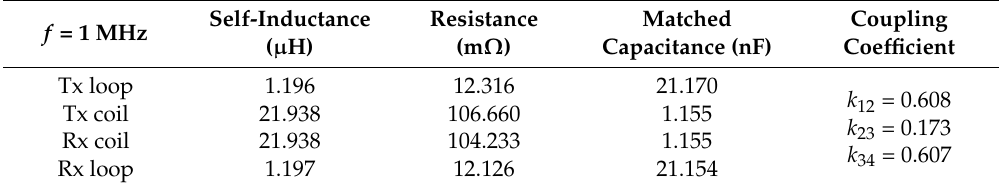
Table 1. Coil parameters without considering the metal effects.